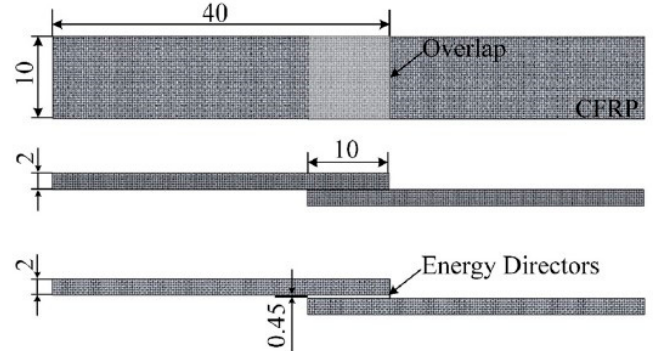
Figure 5. Schematic illustration of joint configuration USW (dimensions in mm). Adapted from Reference [144].